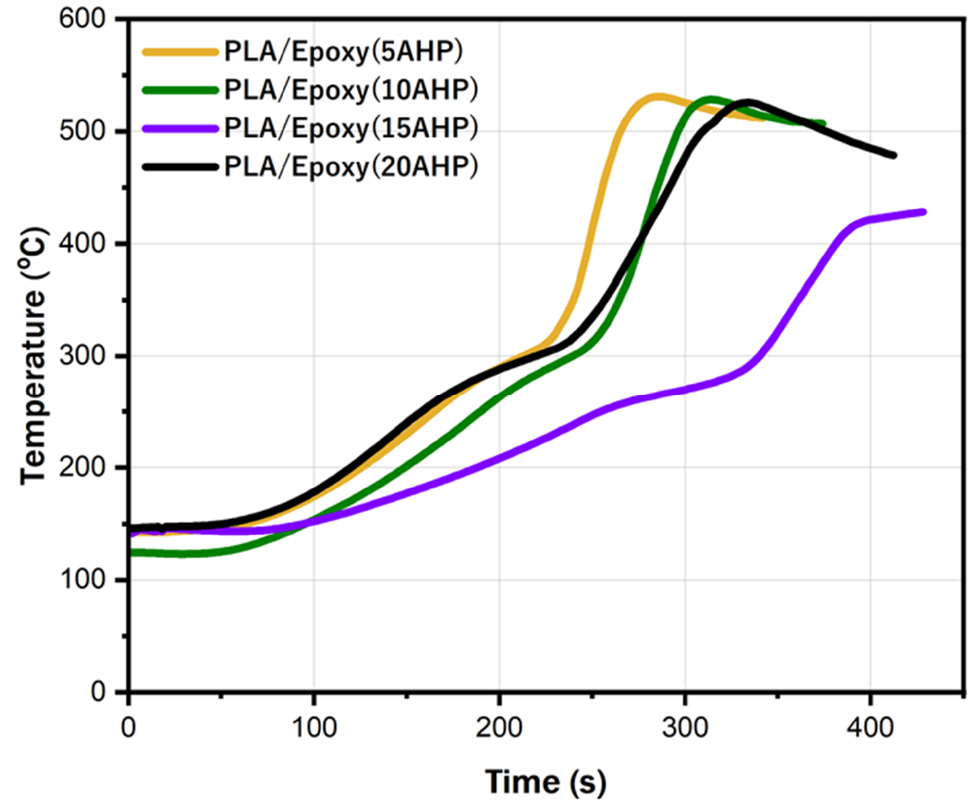
Figure 10. The evolution of the temperature at the non-exposed sides of the plates during cone calorimeter test (35 kW/m²).